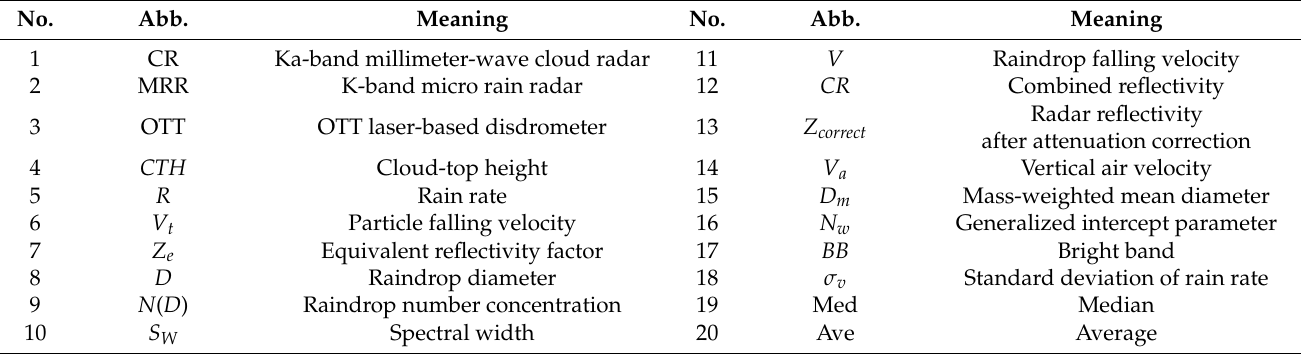
Table A1. List of abbreviations used in this